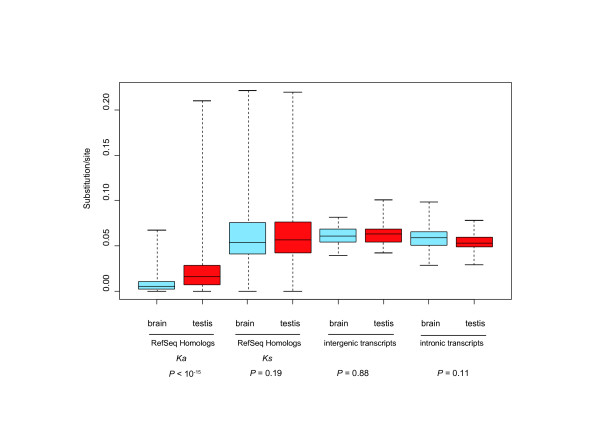
Sequence conservation of the brain-expressed and testis-expressed transcripts between humans and macaques. For the RefSeq homologs (control), the non-synonymous (Ka) and synonymous (Ks) substitution rates were estimated using the Li-Pamilo-Bianchi method [48]. The substitution rates in the intergenic and intronic transcripts were estimated using Kimura's two parameter methods [55]. The heights of the boxes represent the lower and upper quartile points, and the whiskers show the minimum and maximum points.